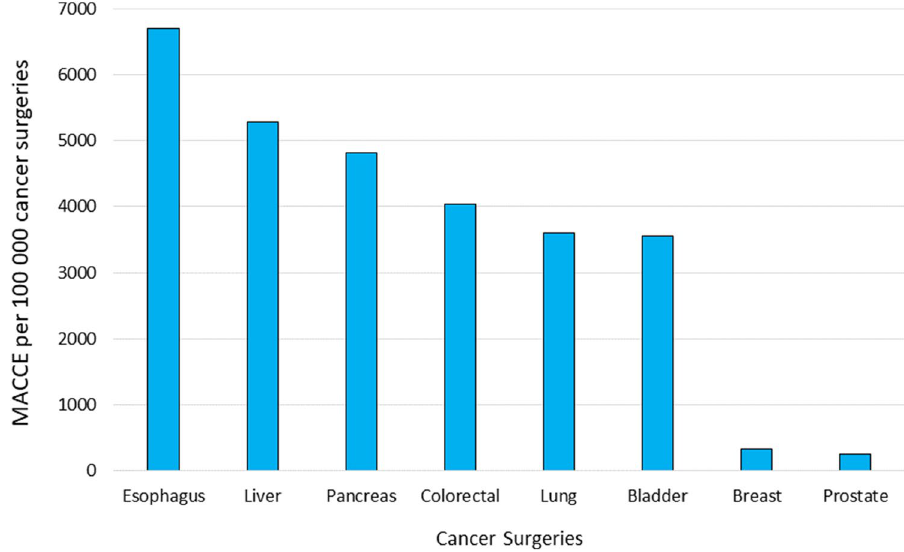
Figure 1. Frequency of perioperative MACCE by type of cancer surgery.